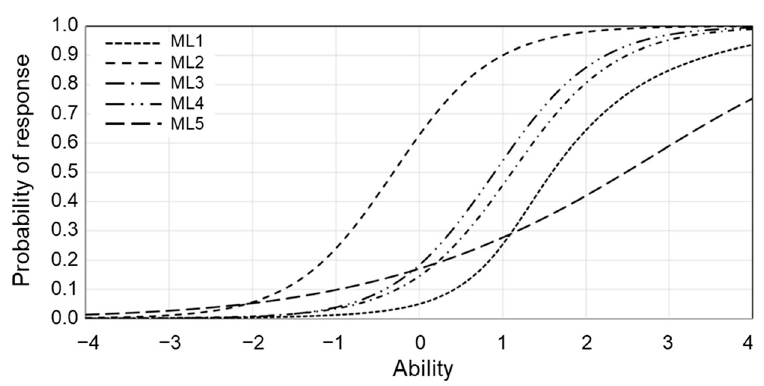
Figure 3. Item characteristic curve for psychosomatic disorder level. x -axis—ability (psychosomatic disorder level). y -axis—probability of response.